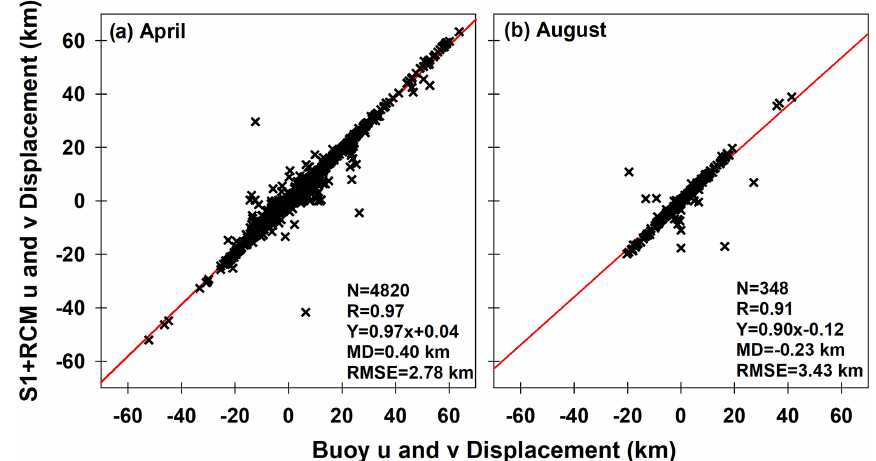
Figure 15. Comparison between ice motion vectors derived by the Komarov and Barber (2014) automated sea ice tracking algorithm from S1 and RCM SAR images and buoy data.